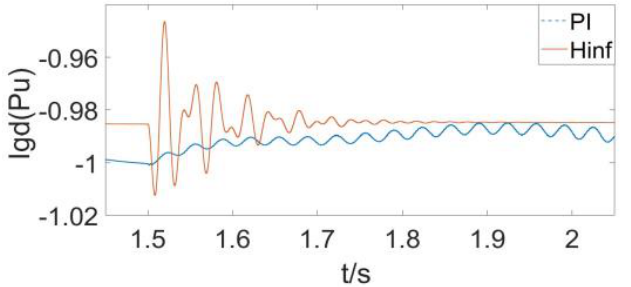
Figure 37. FFT analysis of i gd in the PI controller.